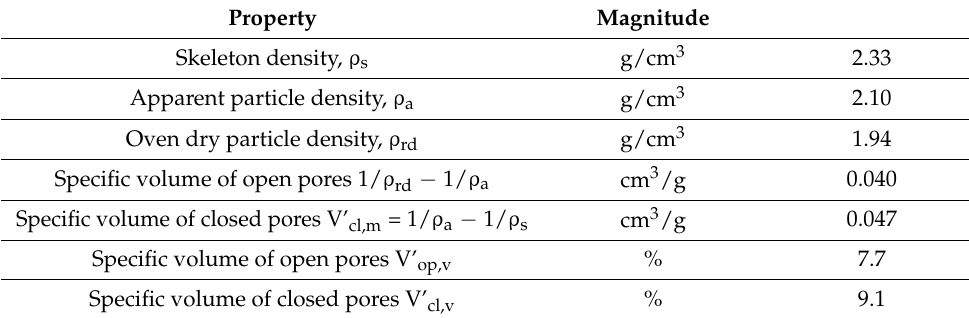
Table 3. Porosity related